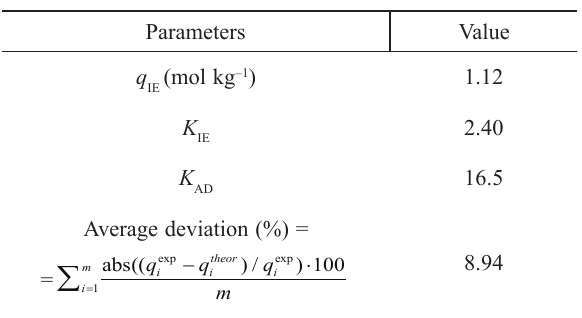
Table 3 – Equilibrium parameters in Eq. (16) of D-GA on the resin 201×7